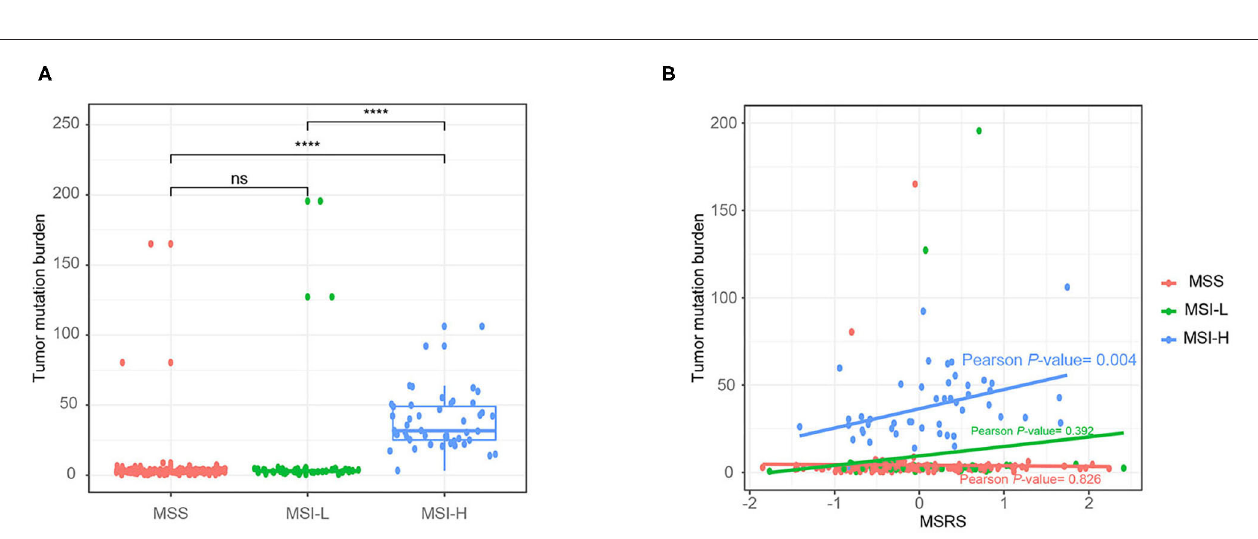
FIGURE 6 | The MSRS has favorable predictive value and validation in the GSE39582 cohort. The Kaplan–Meier (KM) curves (A) indicate that the higher MSRS has poor overall survival and it is indicated in the forest plot (B) . We validated the prognostic value in the external cohort (GSE39582) and the KM curves (C) and the forest plot (D) showed similar results.